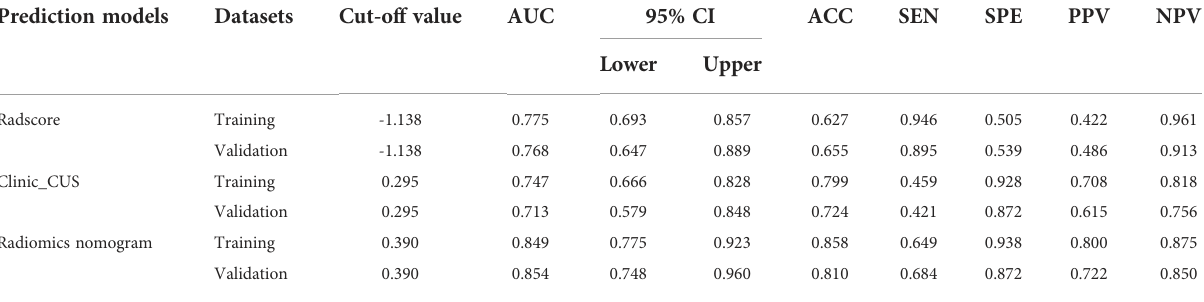
TABLE 7 Diagnostic performance of the Radscore, clinical_CUS, and radiomics nomogram models in the training and validation datasets. Prediction